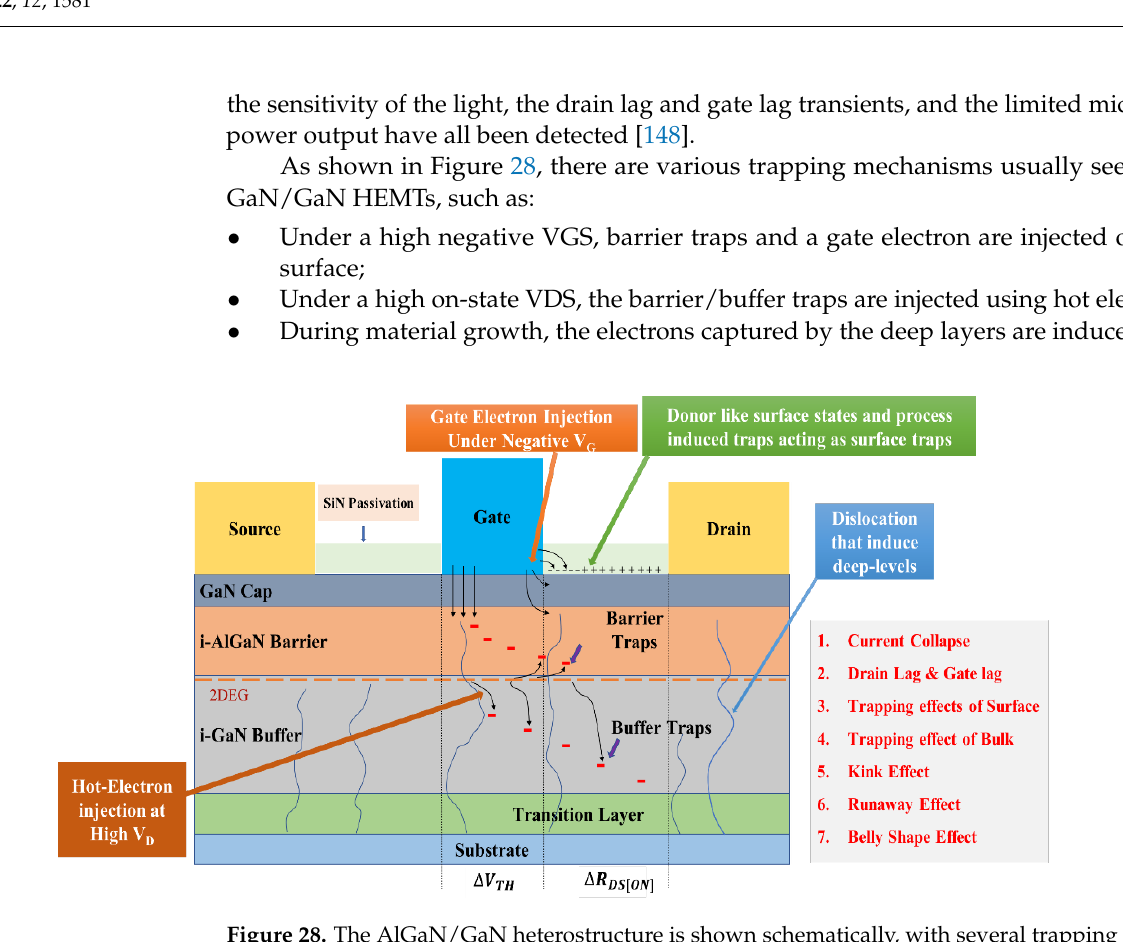
Figure 28. The AlGaN/GaN heterostructure is shown schematically, with several trapping methods and their effects on device performance. Reprinted with permission [149]. Under the terms of the Creative Commons Attribution 4.0